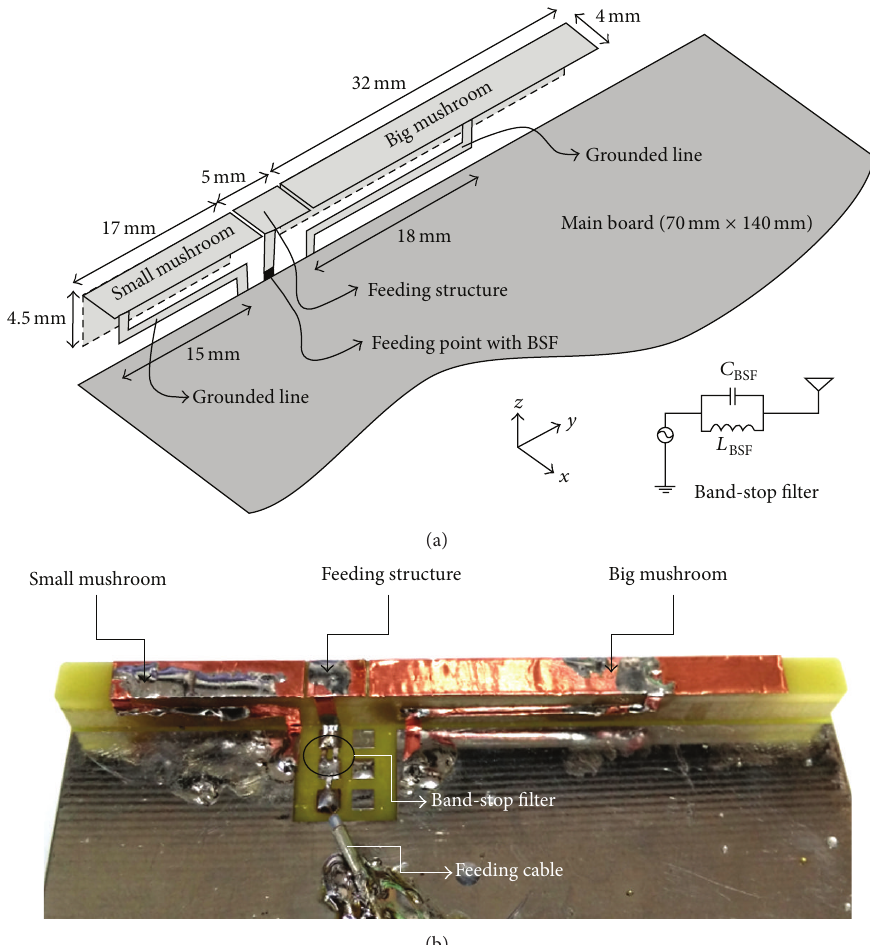
Figure 3: (a) Structure and (b) photograph of the proposed dual ZOR antenna.